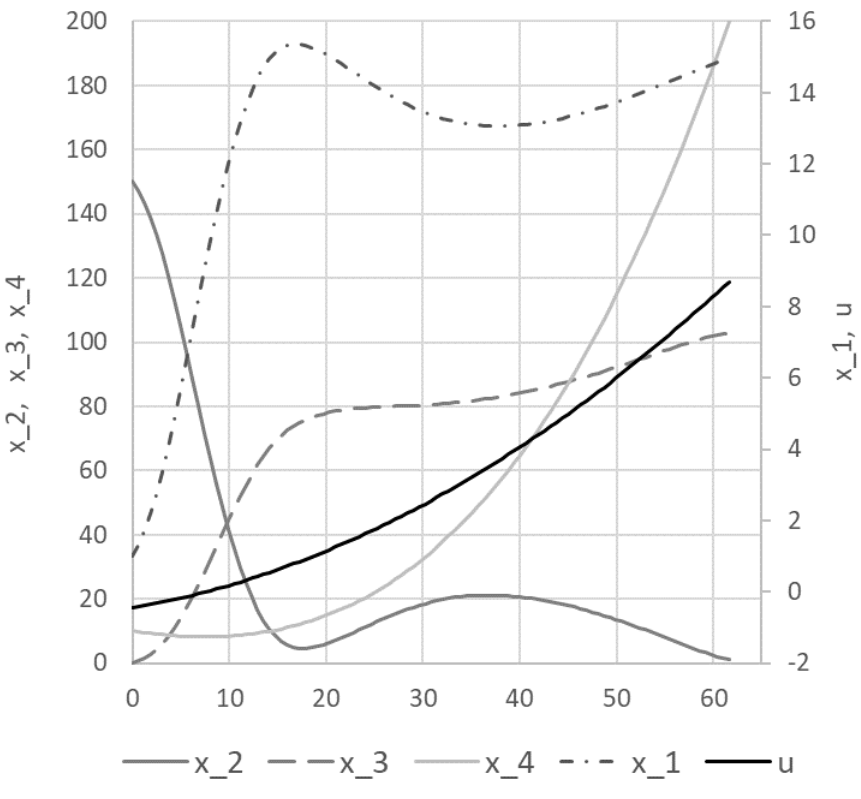
Figure 23 . Optimal trajectories computed by the spreadsheet method for problem 3.4.